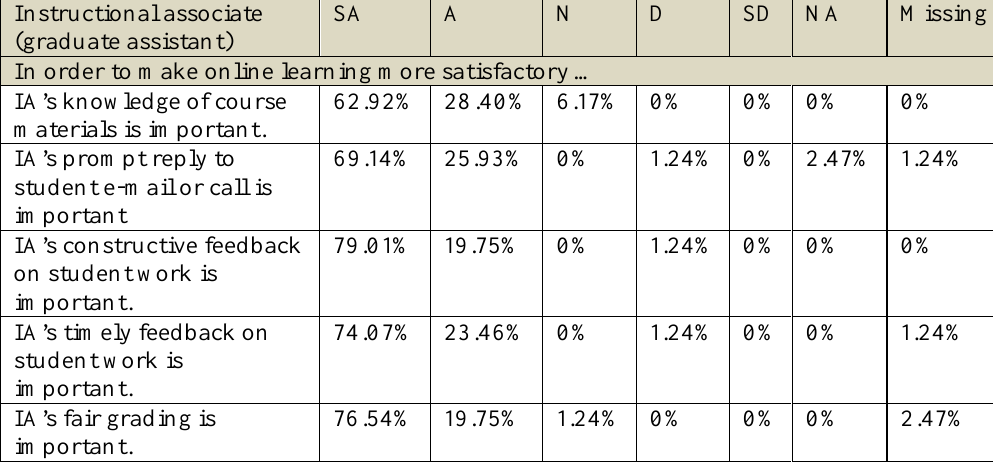
Participants’ Satisfaction Levels Associated with Instructional Associate (IA)